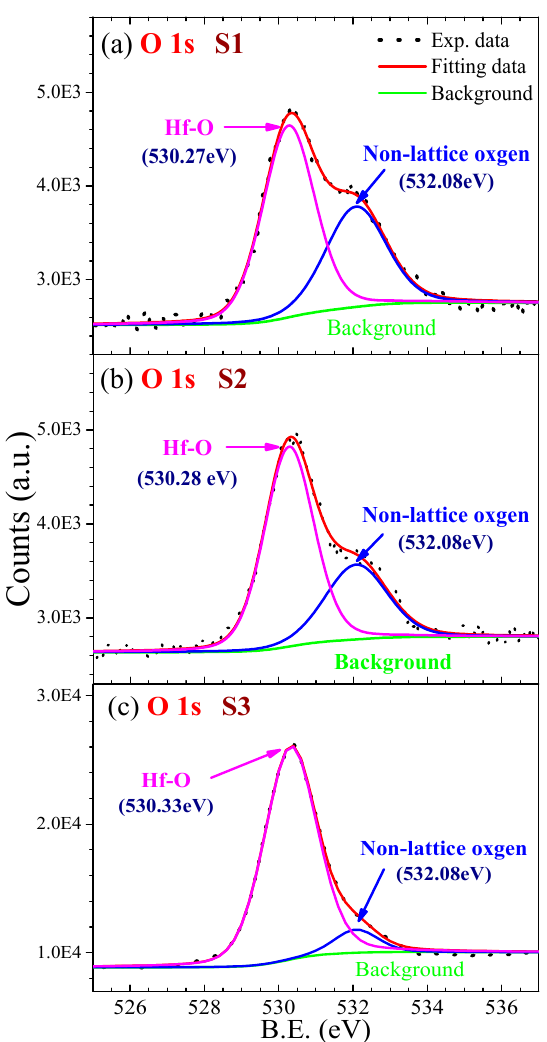
Figure 3. The high-resolution XPS fitting results of the O 1s peaks of S1, S2, and S3 are shown in ( a – c ), respectively, with experiment data (short dash lines), fitting result (red solid lines), and background (chartreuse solid lines).